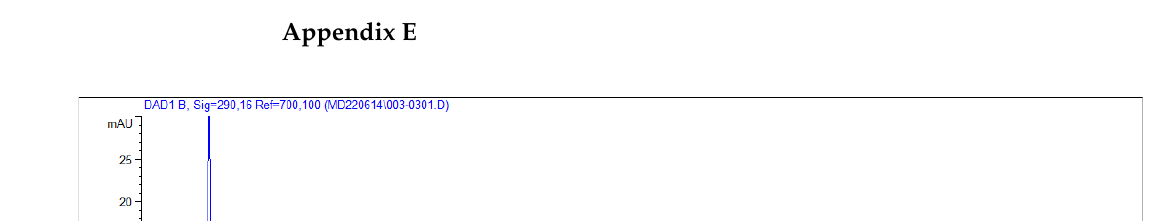
Figure A3. Representative chromatogram of carotenoids identified on the basis of RT and absorp- tion spectra in the extracts of Svevo, Svevo HA, Faridur, Chifaa and lentil 6002/ILWL118/1-1.